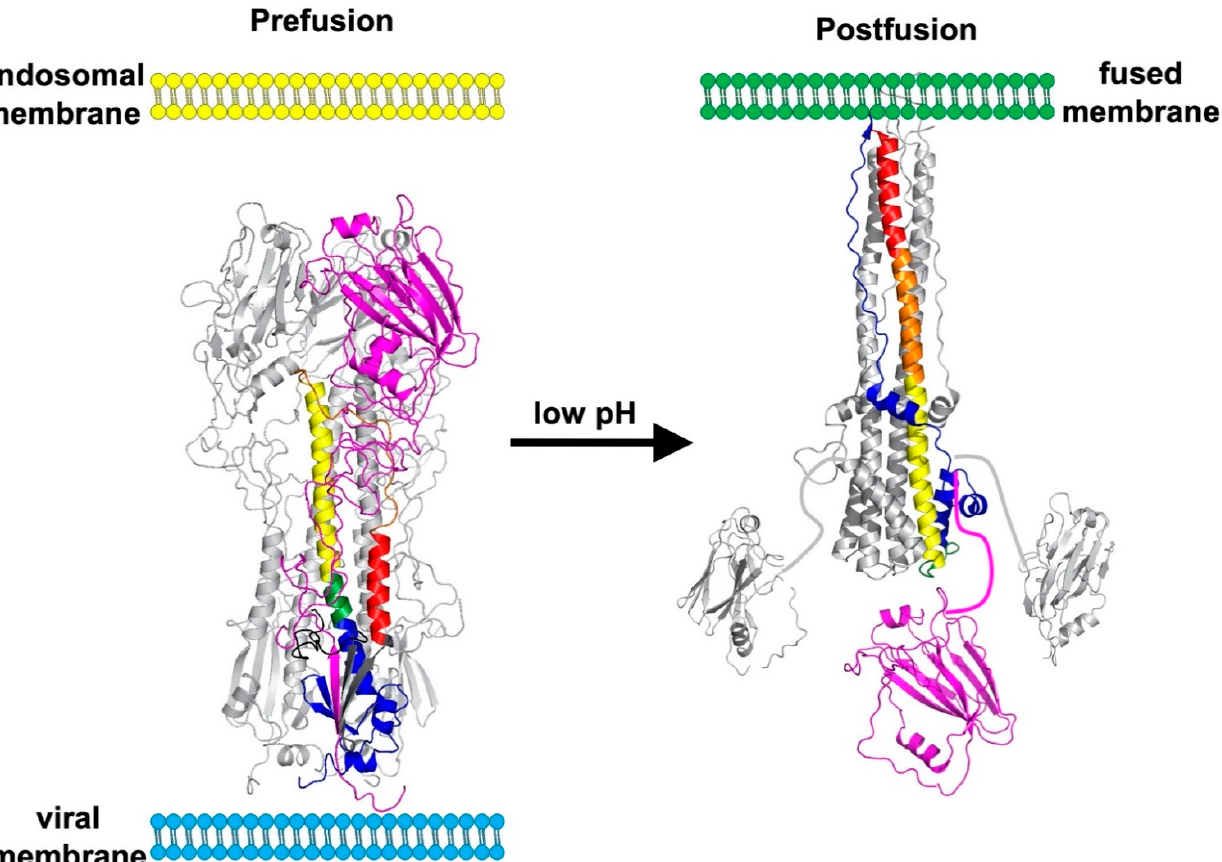
Figure 2. Prefusion and postfusion structures of the HA ectodomain. In the prefusion structure ( left ), the stalk domain is proximal to the viral membrane (blue lipids), and the head domain is oriented toward the endosomal membrane (yellow lipids). Two protomers are colored gray, while the third is colored as follows: HA1 (purple), fusion peptide (black), helix A (red), loop B (orange), helix C (yellow), C–D hinge (green), membrane-proximal residues (blue). After activation by low pH ( right ), the HA protein undergoes irreversible structural changes in which the head domains dissociate from the stalk and HA2 undergoes extensive refolding, helping drive fusion of the two membranes (green lipids). HA2 conformation changes include loop B continuing the central triple-stranded coil formed by helix C, the C–D hinge breaking the central helix, and the membrane-proximal residues forming a buttress antiparallel to the central coiled coil. This topology creates a hairpin structure. Structures were generated using MacPYMOL using X31 (H3N2) HA protein data bank structures 1HGF and 1QU1 [73,101].